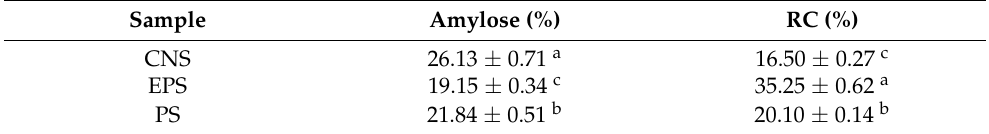
Values articulated are the mean of triplicate ± SD. Values within the same column with different superscript letters are significantly different at p ≤